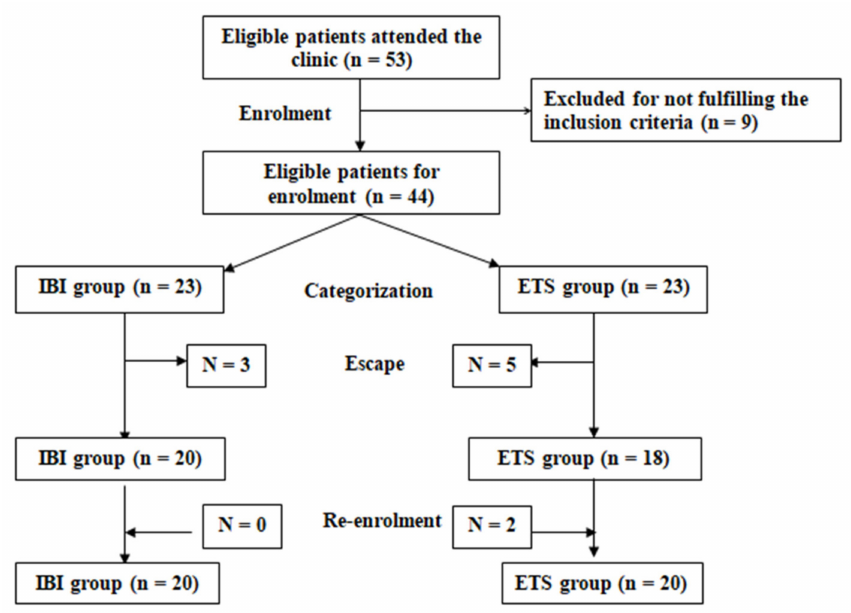
Figure 2. Study Flow